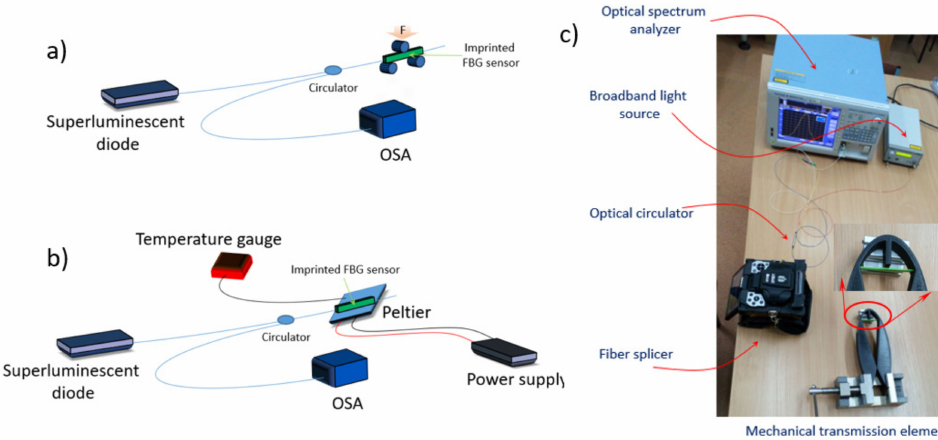
Figure 4. Measurement setups for strain ( a ), temperature ( b ) and compliant mechanism ( c ).